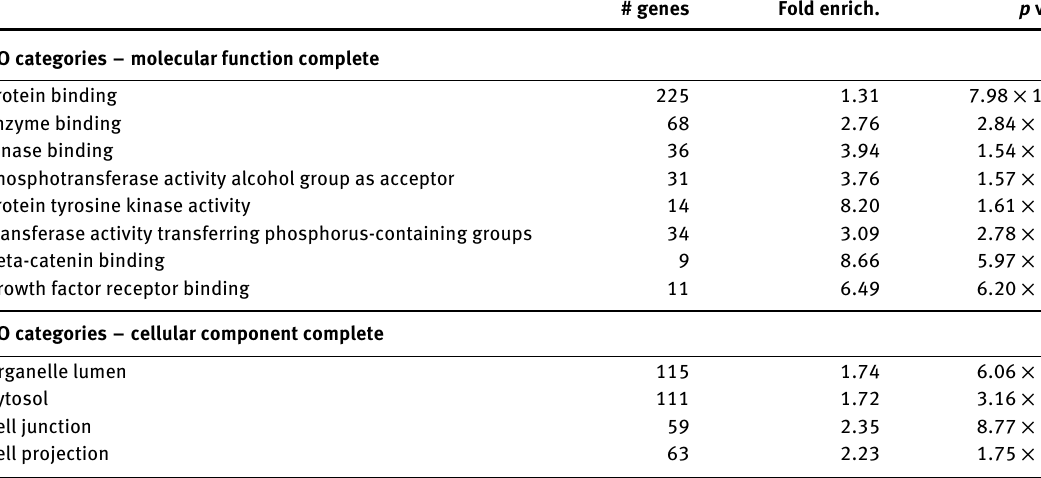
Table 3: Categories of gene ontologies for glioblastoma genes according to PANTHER (molecular functions and cellular